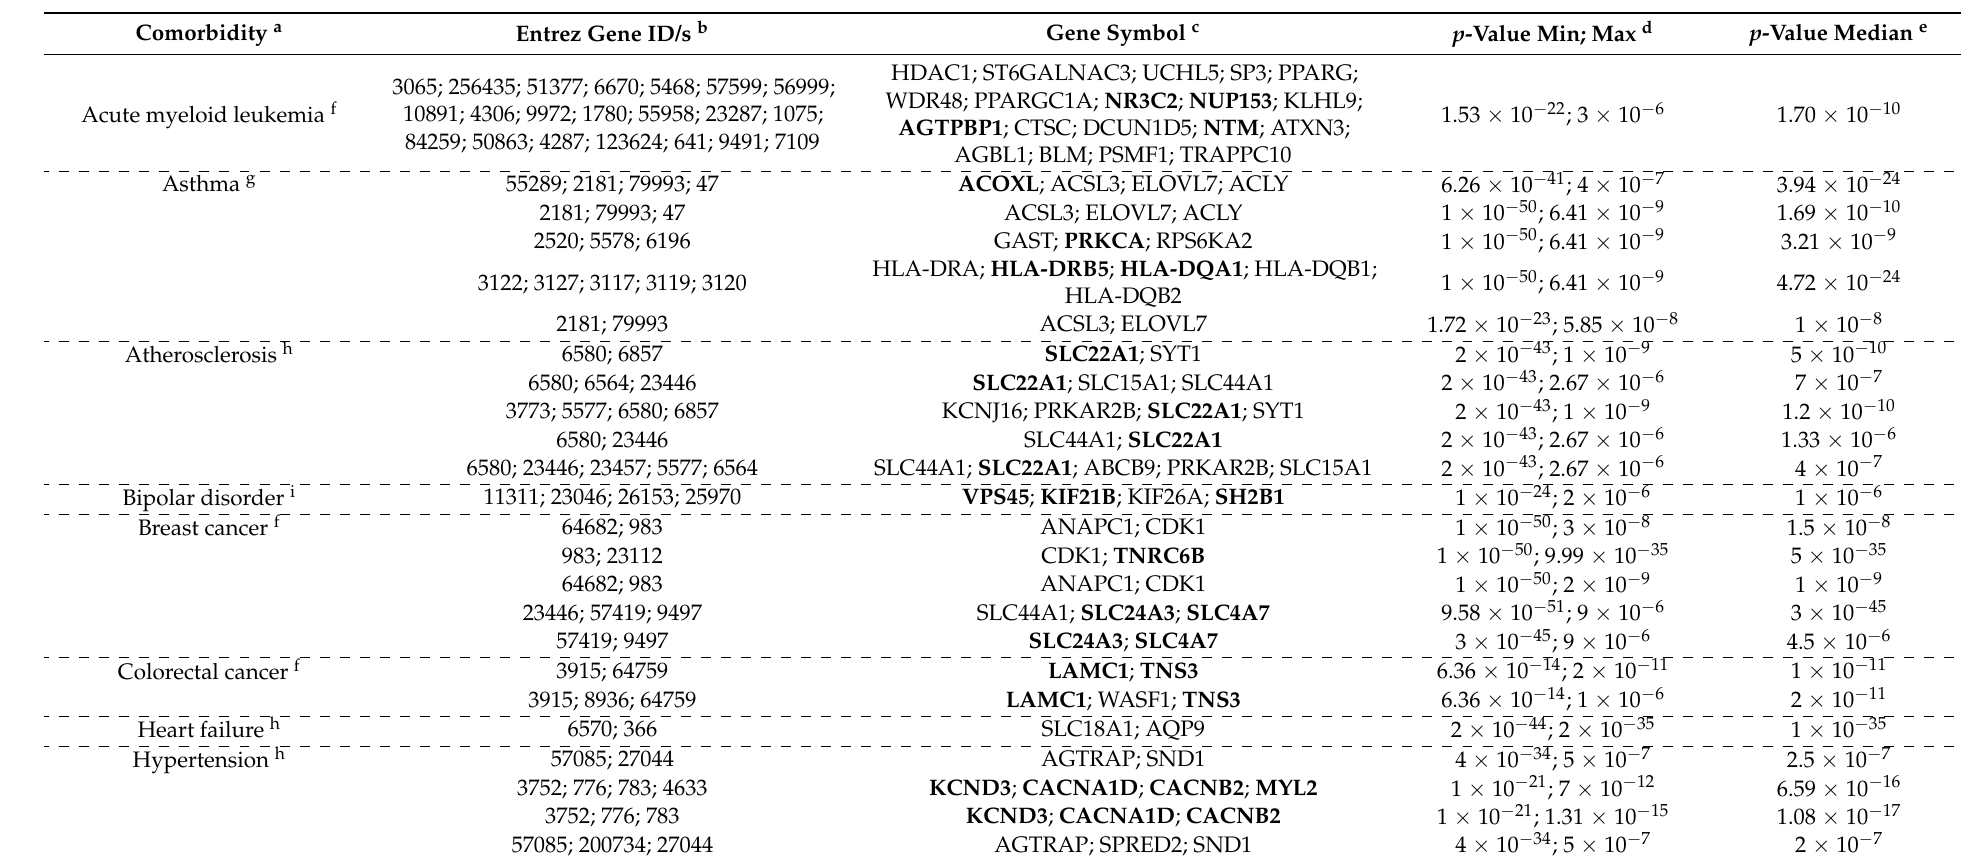
Table 1. Significant COVID-19 comorbidity-associated genes via MAGMAv1.07b. (a) SARS-CoV-2 infection-related possible comorbidity name having significant genes analyzed